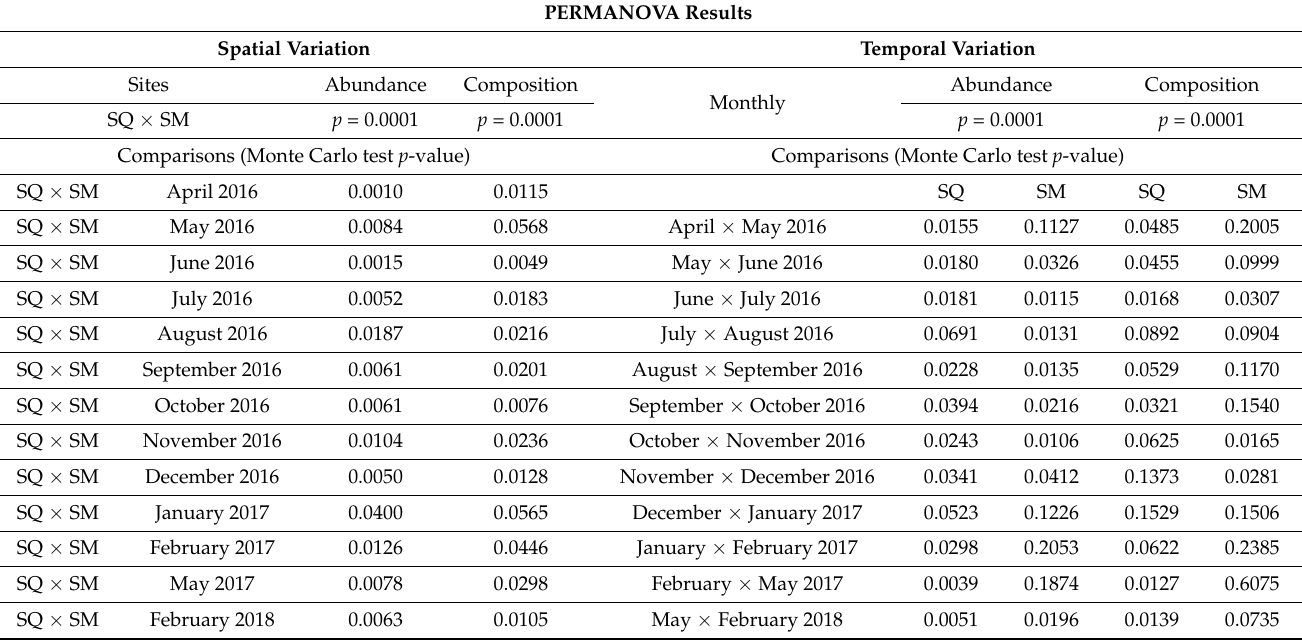
Table 2. Summarized results from the PERMANOVAs. Spatial and temporal variation (monthly) in the abundance and composition of the epiphytic diatom community in R. maritima meadows (Saco da Quit é ria = SQ, Saco da Mangueira = SM). The months are represented in abbreviated form. For the Monte Carlo test, a p value < 0.05 = significant